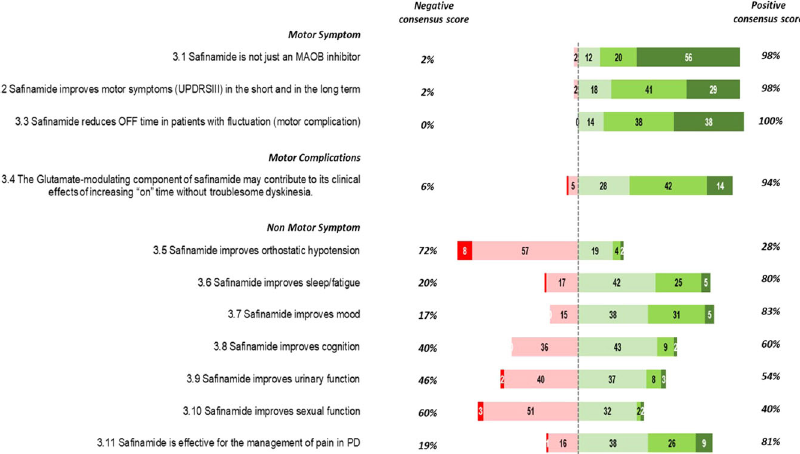
Fig. 3 Delphi questionnaire results: topic 3 “ Ef fi cacy of Sa fi namide ” . Numbers in the colored bars are the total number of votes received for each level of disagreement/agreement (1, extremely disagree; 2, disagree; 3, agree; 4, mostly agree; and 5, extremely agree). The “ negative consensus score ” and the “ positive consensus score3 are percentage.